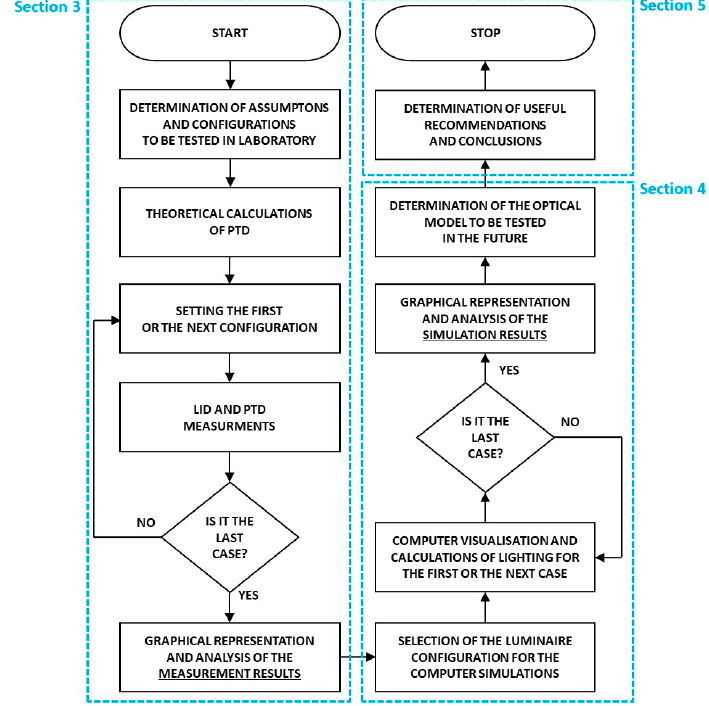
Figure 7. The step diagram of the conducted research.